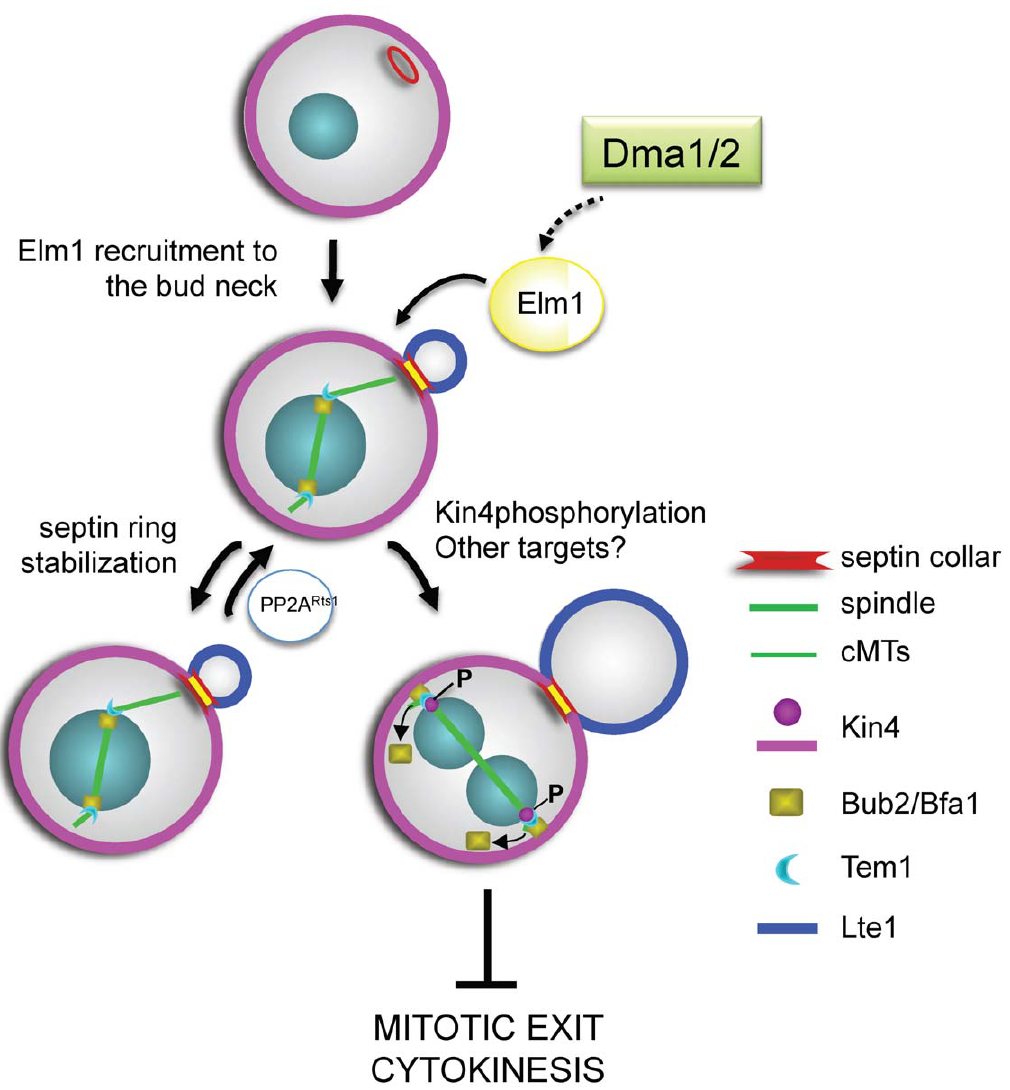
Figure 8. A model for the role of Dma proteins in regulation of septin dynamics and SPOC response. Dma1 and Dma2 control Elm1 recruitment to the bud neck and this promotes both septin ring stability and inhibition of mitotic exit upon spindle mispositioning through phosphorylation and activation of Kin4 and probably of additional targets. PP2A Rts1 counteracts Elm1 functions in septin ring stabilization. See text for further